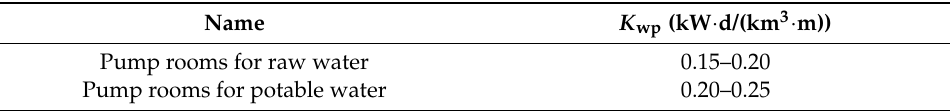
Table 11. Empirical load index of pump rooms in water sources